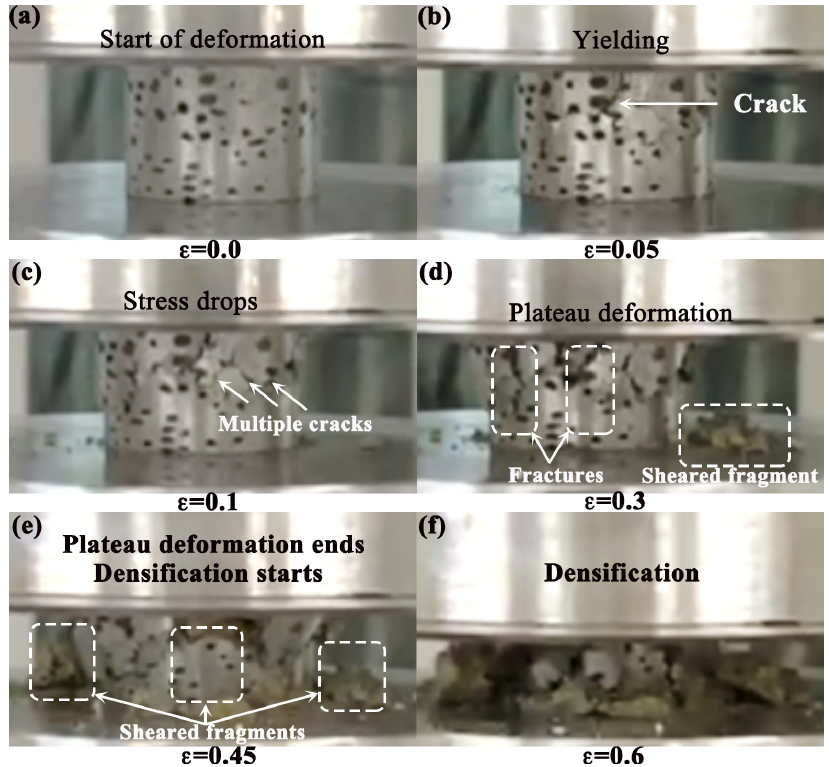
Figure 12. Different stages of deformation behavior straining the porous Mg alloy foams. ( a – f ) are the images to demonstrate the foam after compressed to the strains ( ε ) of 0.0, 0.05, 0.1, 0.3, 0.45 and 0.6, respectively.